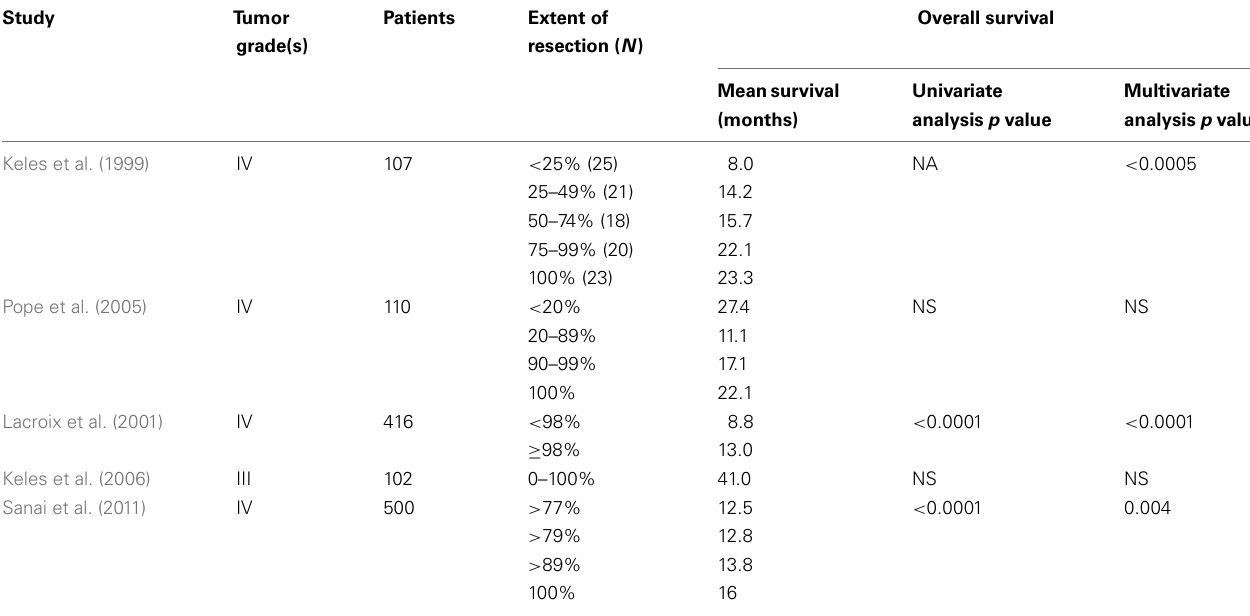
Table 1 |Volumetric EOR studies in high-grade